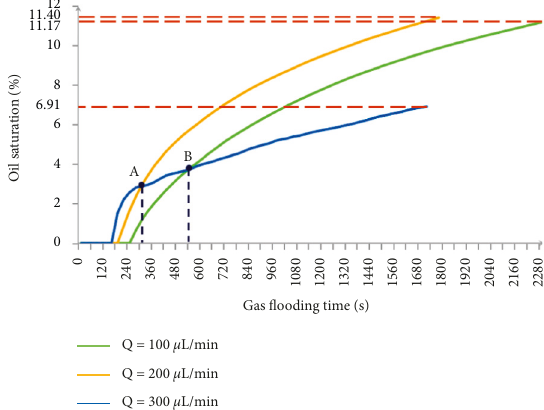
Figure 9: The continuous gas injection time-TSD curve at diverse gas injection